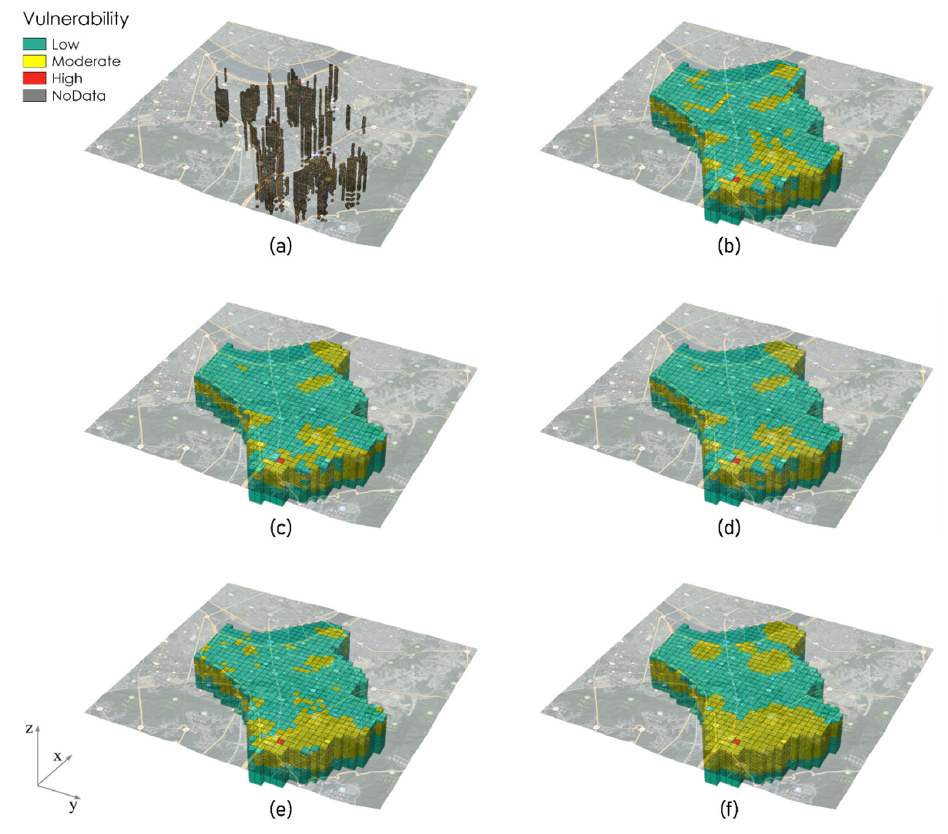
Figure 10. Improved IDW interpolation results: ( a ) Borehole data applied with elevation exaggeration factor; ( b ) NP − Ⅰ ; ( c ) NP − Ⅱ ; ( d ) NP − Ⅲ ; ( e ) FD − Ⅰ ; ( f ) FD − Ⅱ .